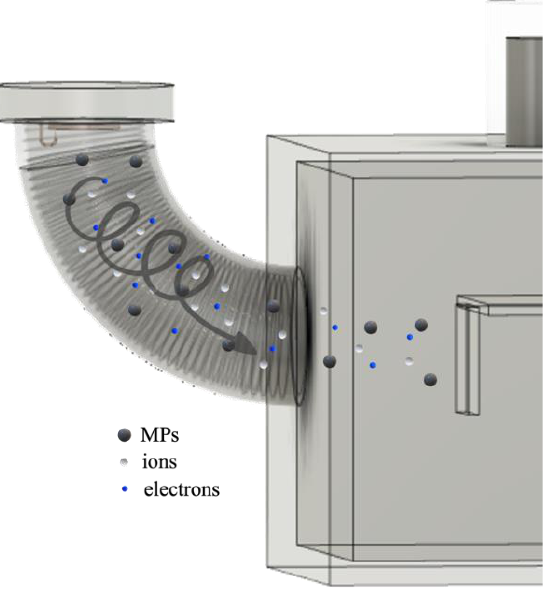
Figure 9. Schematic diagram showing the entrainment mechanism of MP transport.